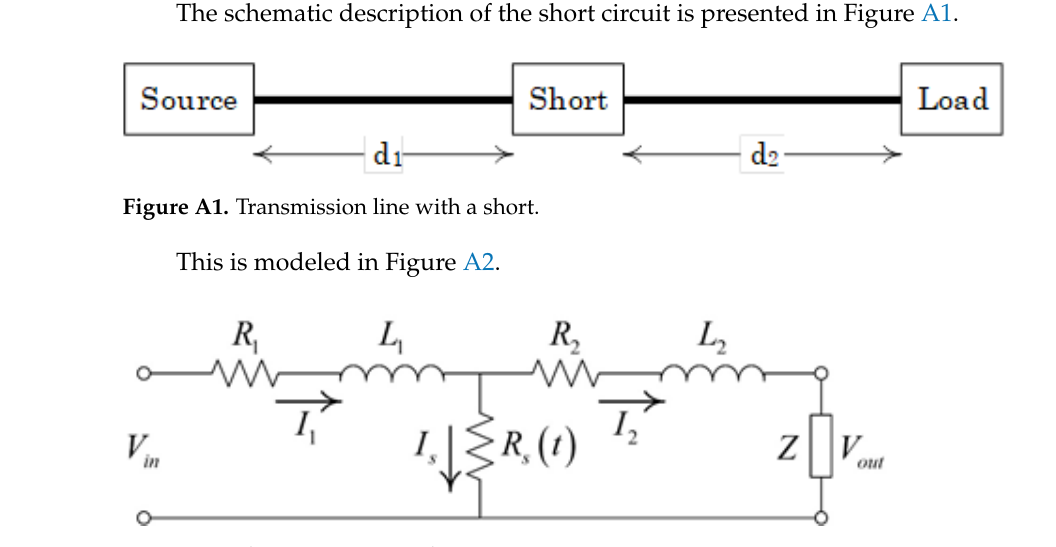
Figure A2. Short circuit